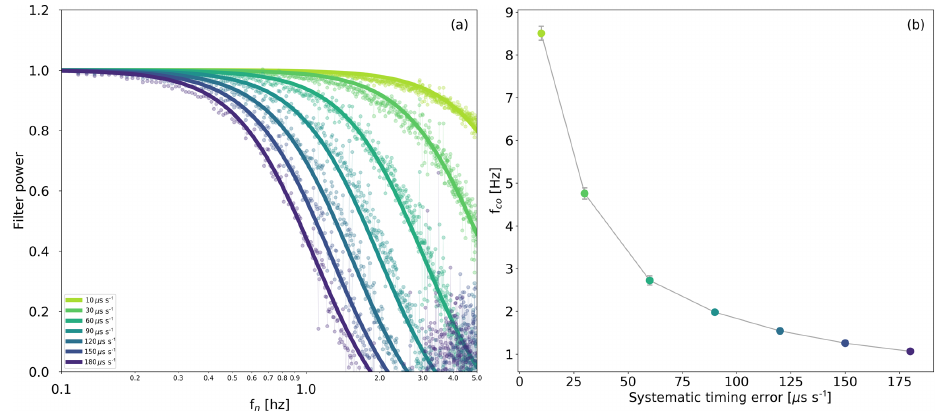
Figure 6. Transfer function for the STE at different error amounts, as derived using Eqs. (2) and (3), using data from site IT-CA3 (a) . Mean values and 3.5 σ ranges of the transfer function cutoff frequencies across the fours sites, as a function of the error amount (b)